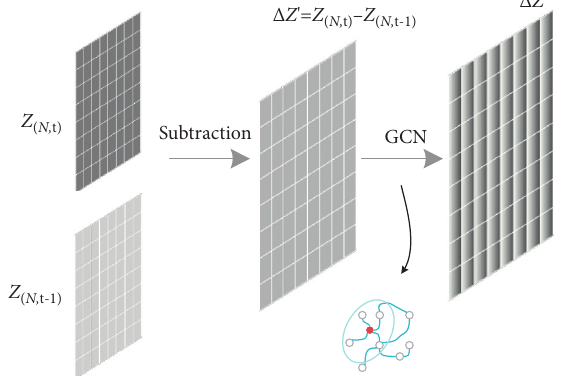
Figure 4: The architecture of Diff-GCN.